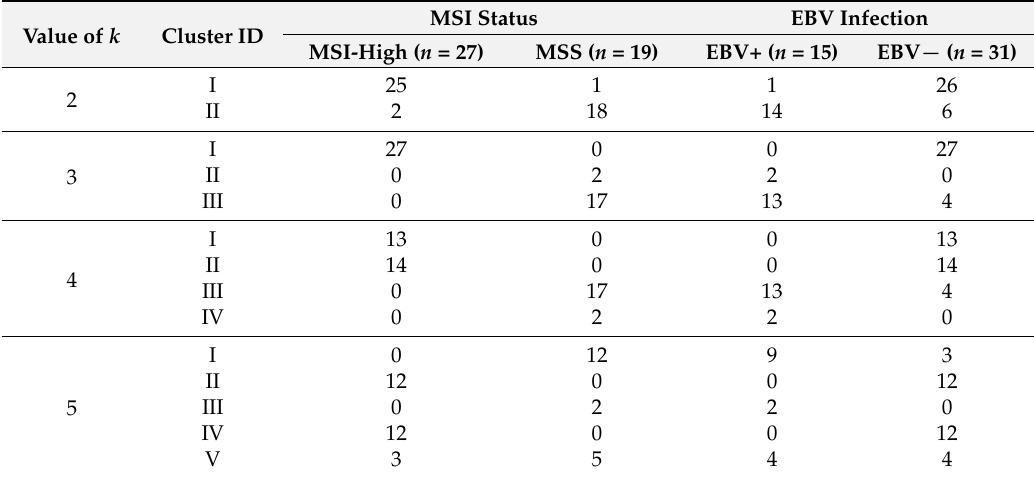
Table 1. Clustering results using a k -means approach. Represented is the number of MSI-high/MSS and EBV+/EBV − cases obtained in each cluster for each k